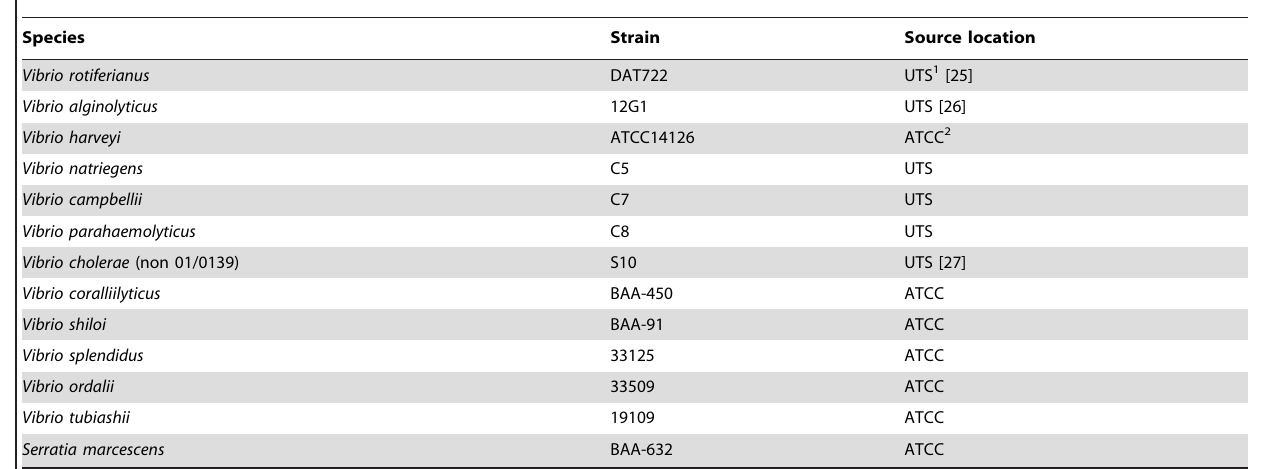
Table 1. Bacterial strains used in this study.